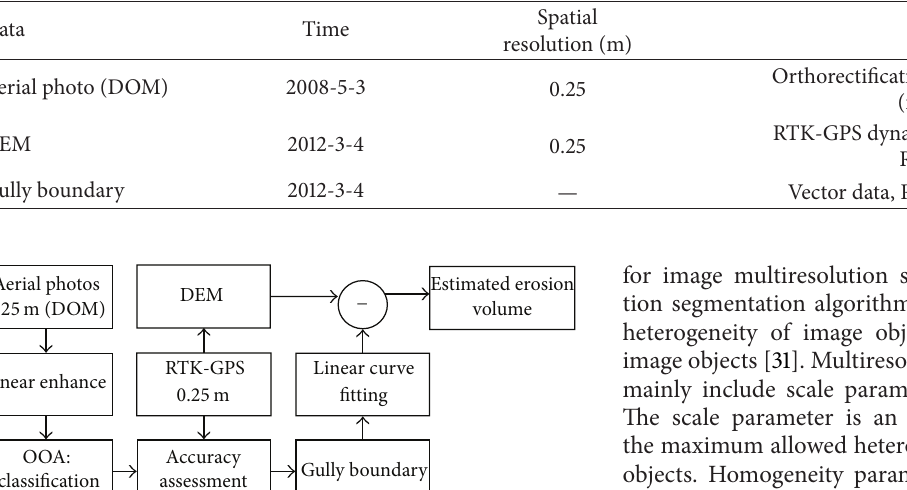
Table 1: Basic information of the experiment data.